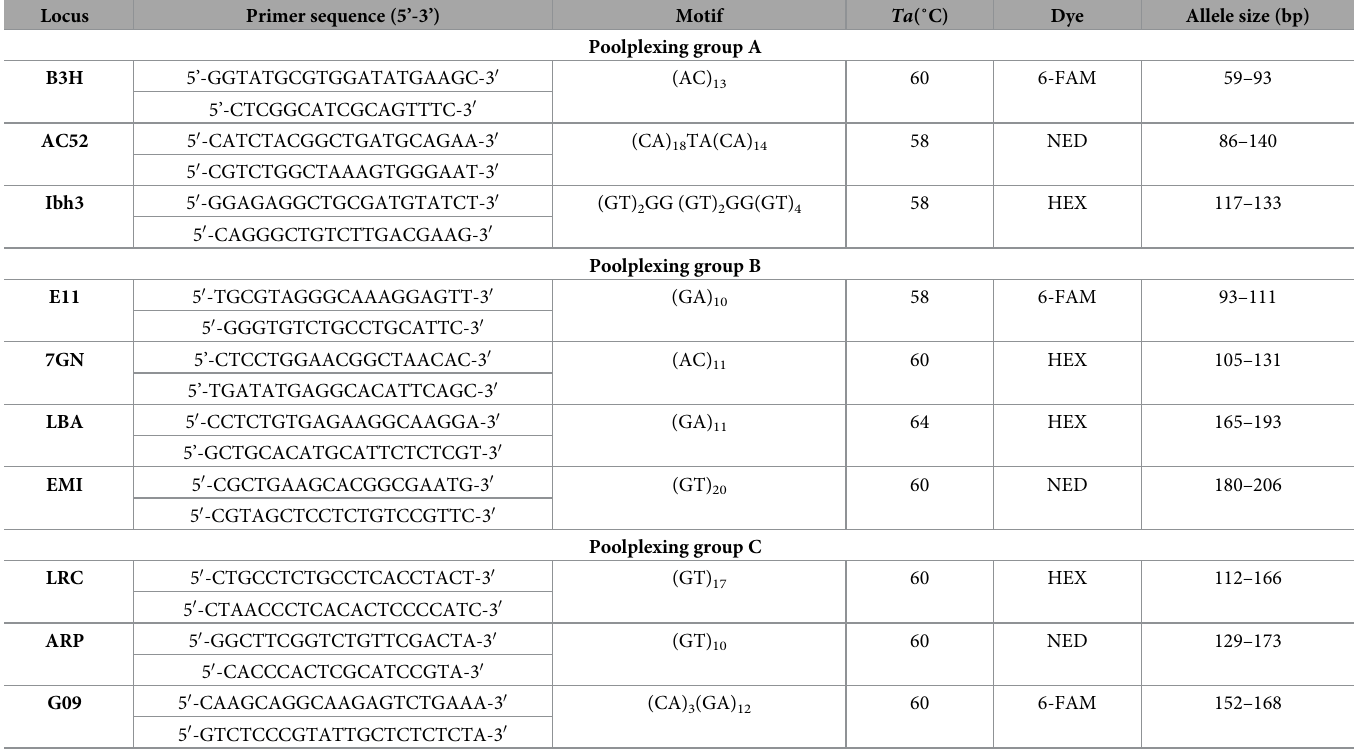
Table 1. Characteristics of microsatellite markers used in this study.